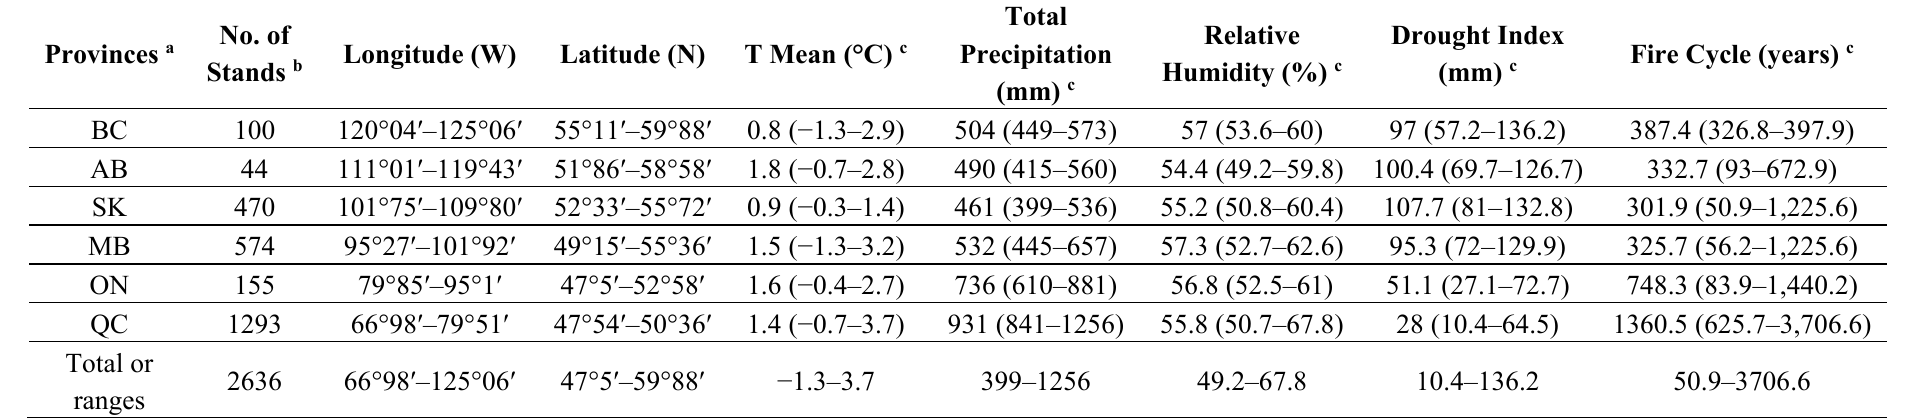
Table 1. Summary of trembling aspen study stands (by Canadian province) with longitudinal and latitudinal ranges and average site